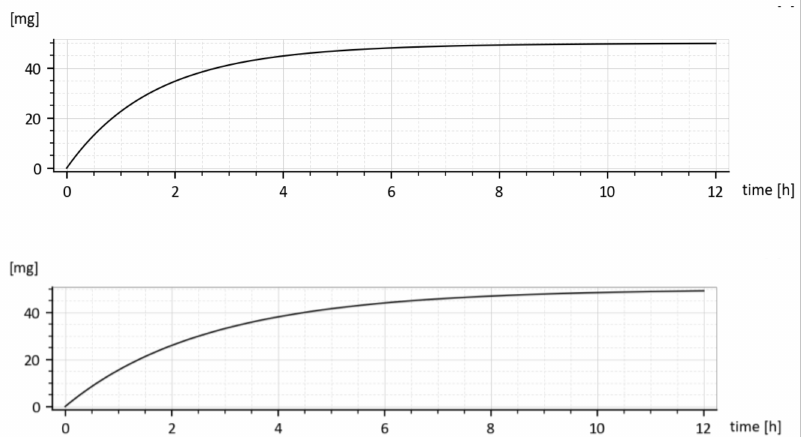
Figure 10. Cumulative amounts of the eliminated drug from the 1st compartment for 1st triplet in (15) ( above ) and the 2nd triplet in ( below